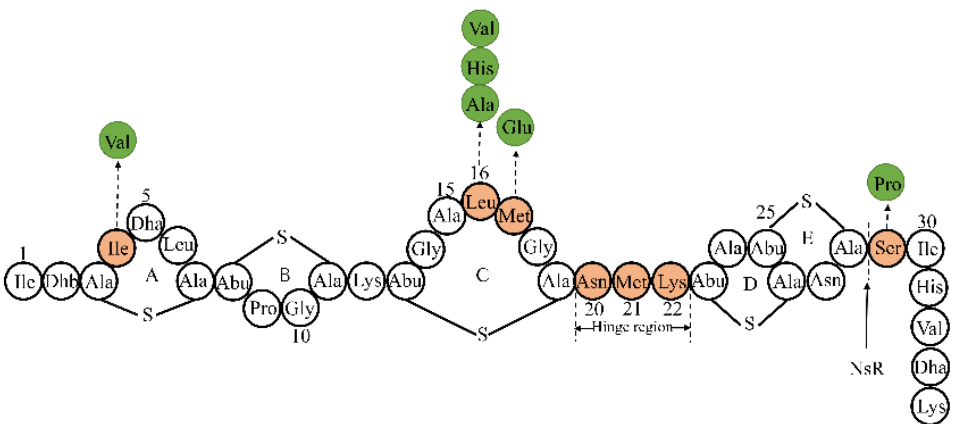
Figure 2. The secondary structure of nisin and some typical valuable variants. Abbreviations: Dha: 2,3-didehydroalanine; Dhb: 2,3-didehydrobutyrine; Abu: 2-aminobutyric acid; NSR: nisin resistance protein. The position indicated by the arrow is the main recognition site of NSR. Light orange-labeled sites are promising mutation sites. There are potential substituted amino acids in the green circles.